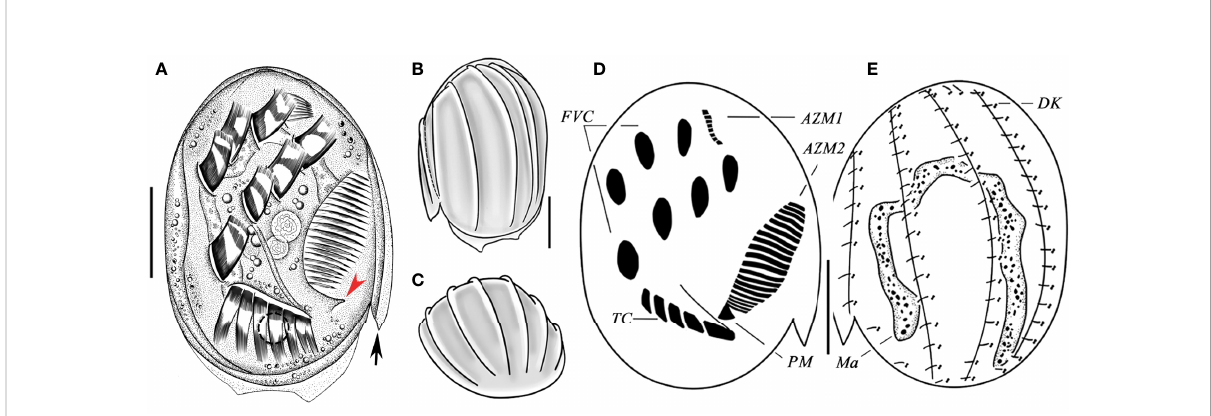
FIGURE 2 Aspidisca spina sp. n. from life (A – C) , and after protargol staining (D, E) . (A) Ventral view of a typical individual; arrow marks spur, and arrowhead marks the bulge. (B, C) Dorsal (B) and apical (C) views, showing the ridges. (D, E) Infraciliature of ventral (D) and dorsal (C) sides of the same specimen. AZM1, anterior portion of adoral zone membranelles; AZM2, posterior portion of adoral zone membranelles; DK, dorsal kineties; FVC, frontoventral cirri; Ma, macronucleus; PM, paroral membrane; TC, transverse cirri. Scale bars: 20